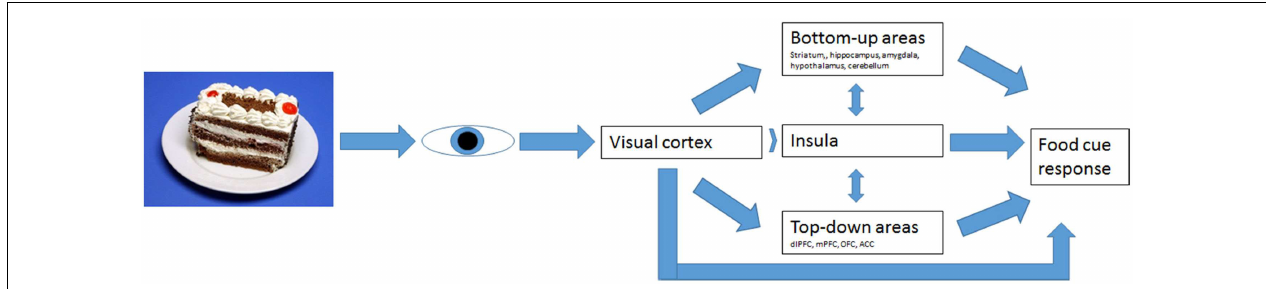
FIGURE 1 | Bottom-up and top-down regulation of visual food-cue responses according to Brooks’ model